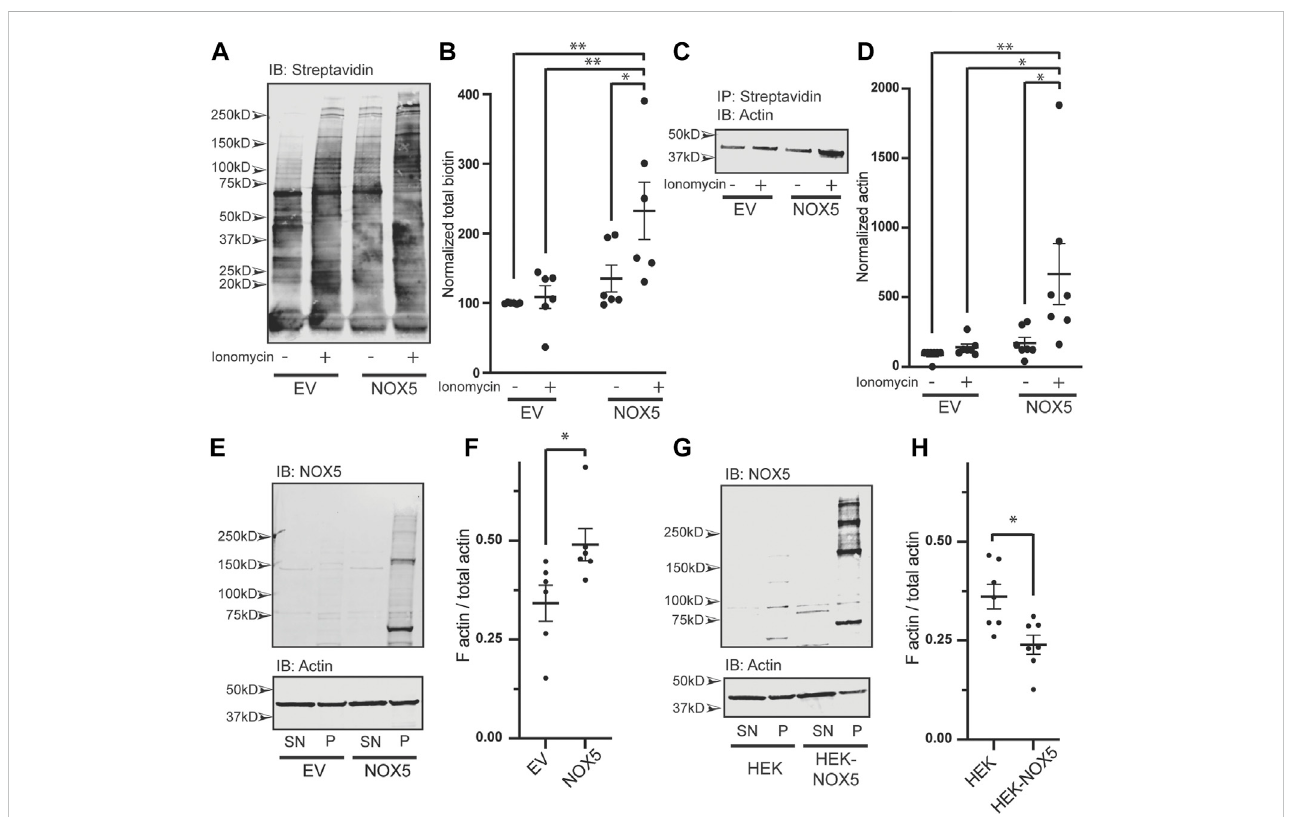
FIGURE 4 NOX5 expressionand activity enhances oxidative modi fi cation of actin and shifts theF/G actin ratio in thecell. HEK293 cells were transiently transfected withemptyvector(EV)orNOX5andthentreatedwithDMSOcontrolor1 μ Mionomycincalciumfor5 min.Aftertreatmentcellswerelysedandsubjectedtoa biotin switch assay to labelcysteineresidues whichhadbeen reversibly oxidized inthecell.Biotinylatedproteinswerepulled out usingstreptavidinbeads and analyzed by western blot. (A) Representative western blot showing biotin labeling in transfected cells with quanti fi cation shown in (B) . Values represent means ± SEM, n = 6. Differences in total biotin labeling between the samples was assessed using a one-way ANOVA with Tukey ’ s test with * denoting p < 0.05 and ** p < 0.01. (C) Representative western blot of biotin switch samples co-immunoprecipitated using streptavidin beads and then blotted for β -actin. (D) Quanti fi cationofbiotinlabeled β -actinwithvaluesrepresenting means±SEM, n =7.Differencesinbiotinlabeledactinbetweenthesampleswasassessed using aone-way ANOVA withTukey ’ stestwith *denoting p < 0.05 and ** p < 0.01.The fi lamentous to freeglobular actin ratio(F/G) wasdetermined usingthe F-Actin/G-Actin InVivo AssayBiochemKit(Cytoskeleton)fortransientlytransfectedHEK293cells[EVvs.NOX5, (E,F) ]andHEK293cellsvs.HEK293cellsstably expressing NOX5 (G,H) . Representative western blots of actin and NOX5 found in the supernatant (SN) vs. pellet (P) are shown in (E) (transient transfectants) and (G) (stable expression) with quanti fi cation in (F) (transient transfectants, valuesrepresent means ± SEM, n = 6) and (H) (stable expression, valuesrepresent means± SEM, n = 7).DifferencesintheF/G actin ratio wereassessedusing Student ’ s t -testwith *denoting p < 0.05. Full blots can befound inSupplementary